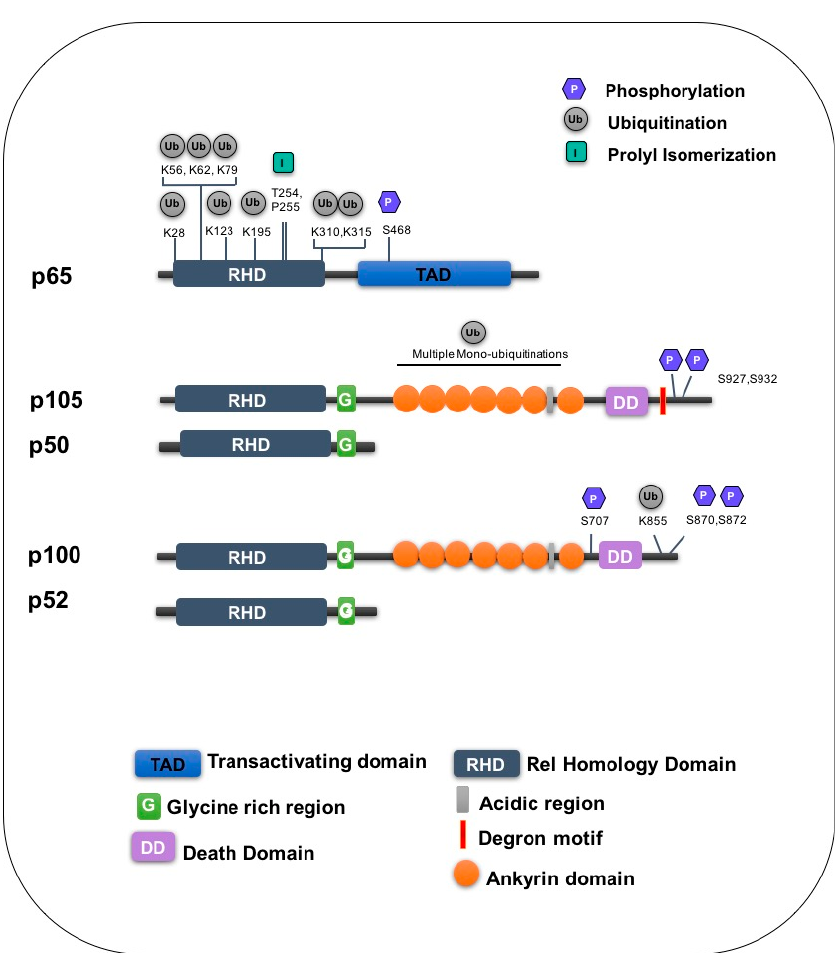
Figure 3. Post-translational modifications associated with the ubiquitination of NF- κ B subunits. Schematic representation of the NF- κ B subunits with known post-translational modifications associated with NF- κ B ubiquitination indicated. RHD: REL homology domain, TAD: transactivating domain, G:glycine rich region, DD: Death domain.